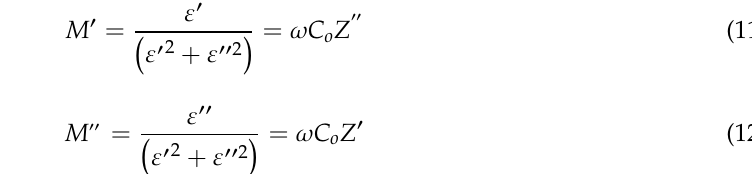
Figure 7. Dielectric loss in opposition to frequency logarithmic scale for all the electrolytes.